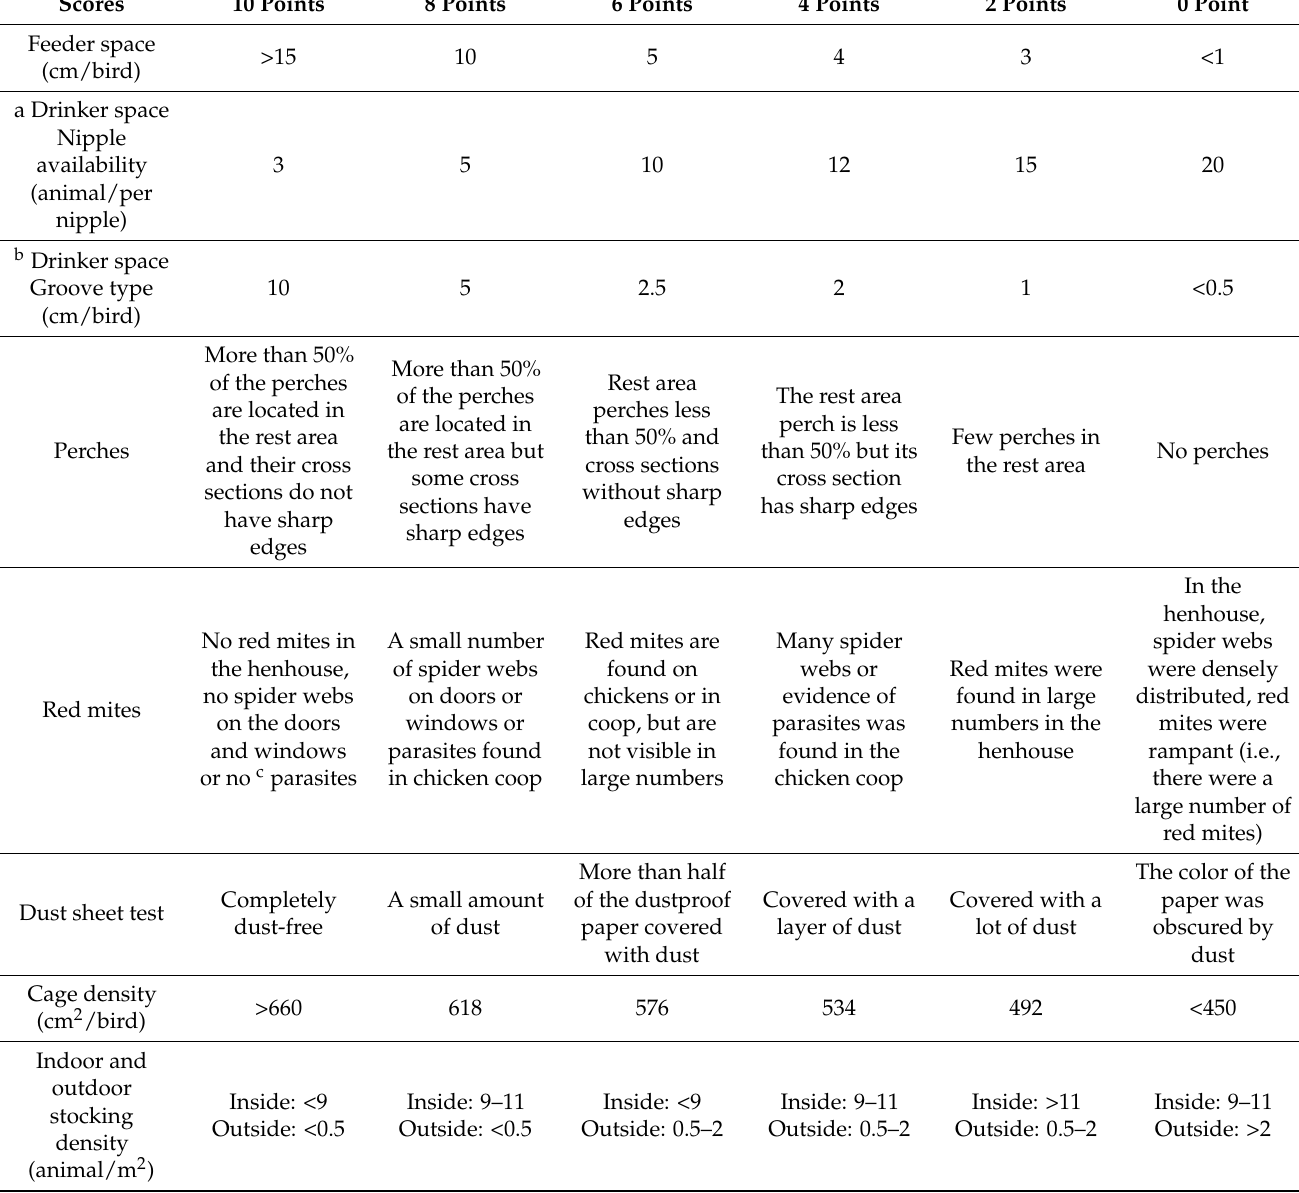
Table 2. Scoring for environmental